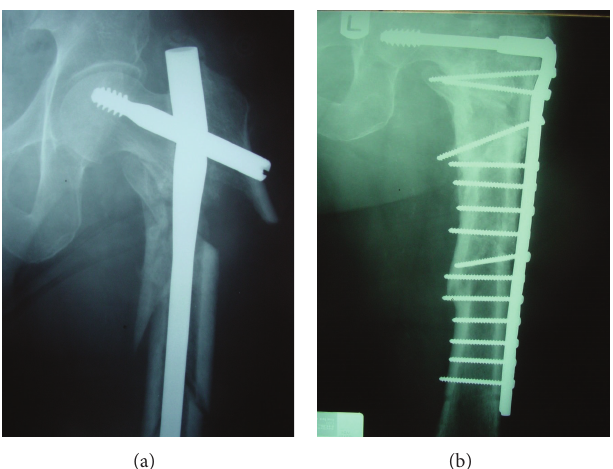
Figure 1: AP radiograph of a complex intersubtrochanteric fracture of femur, showing a broken long TGN at the junction of the nail with the lag screw (a). The nail was revised to DCS plate and the fracture healed at 4 months postoperatively (b).